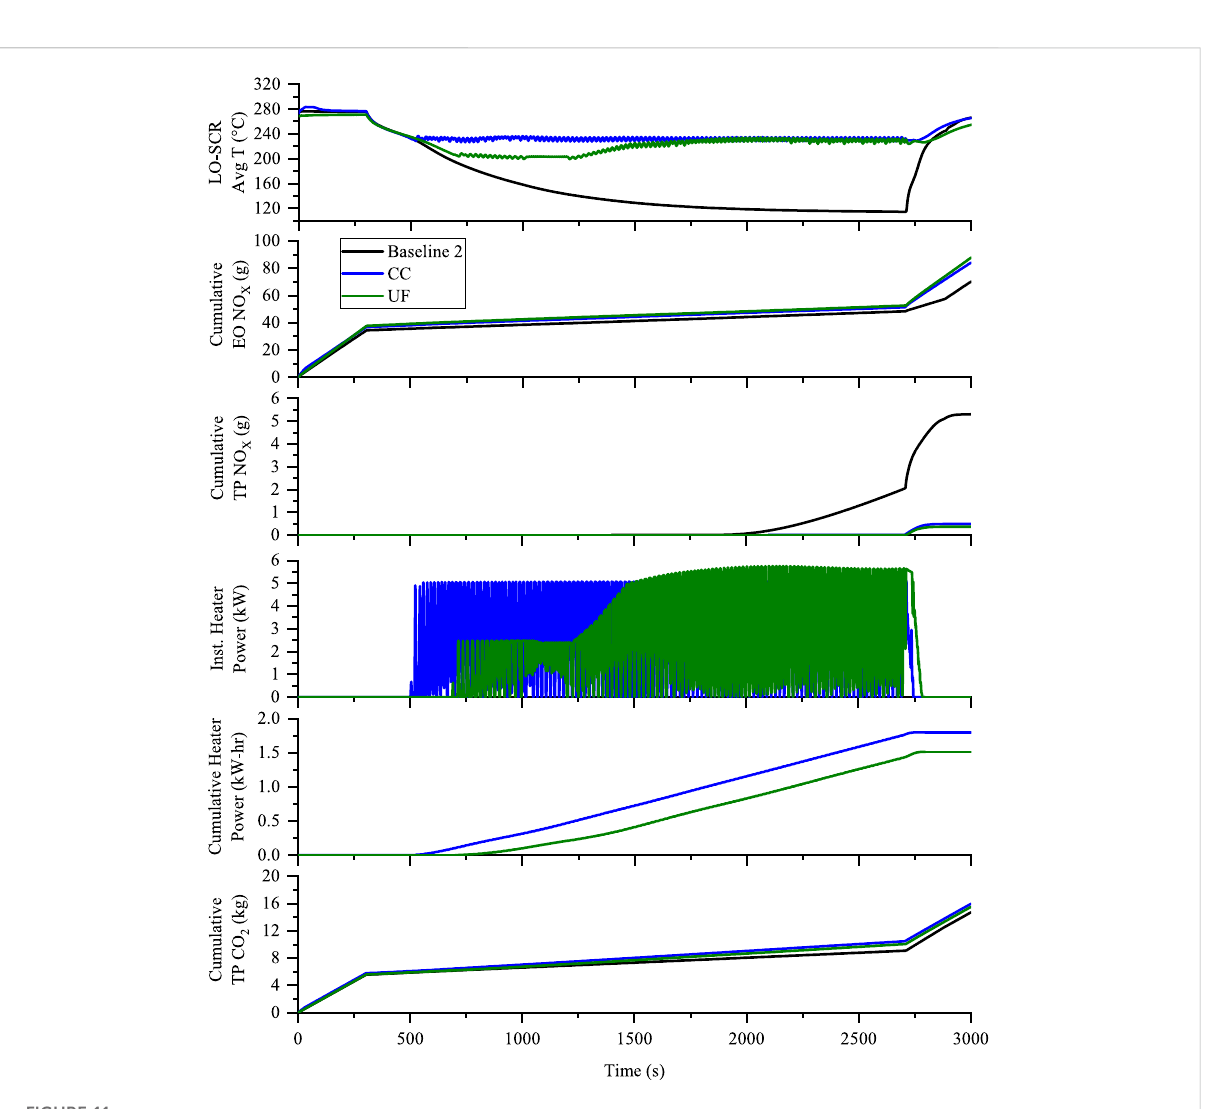
FIGURE 11 Comparison oftheCCLO-SCRandUFLO-SCRtoBaseline 2ontheStayHotcyclefortheLO-SCRaveragetemperature,emissions,andheater electrical power